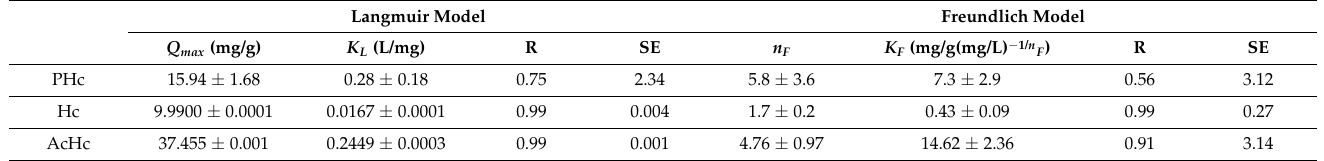
Table 3. Parameters obtained from equilibrium model fittings (value ± standard error of the coefficient). Langmuir Model